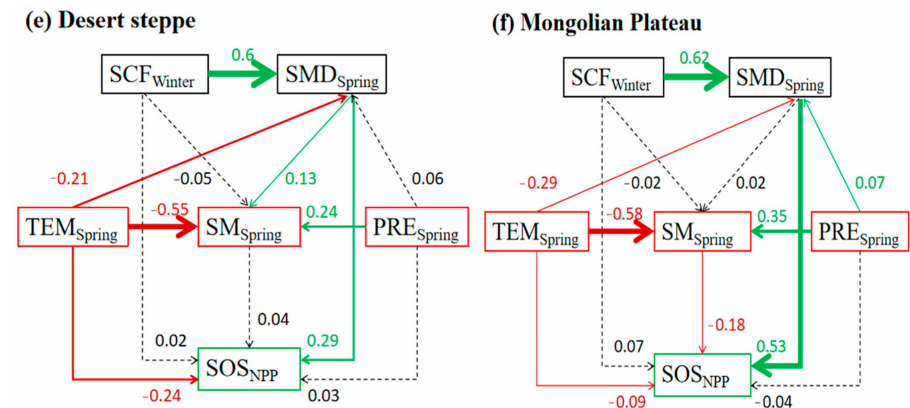
Figure 6. Different vegetation types of 2001–2019 grey relation grade of SOS NPP